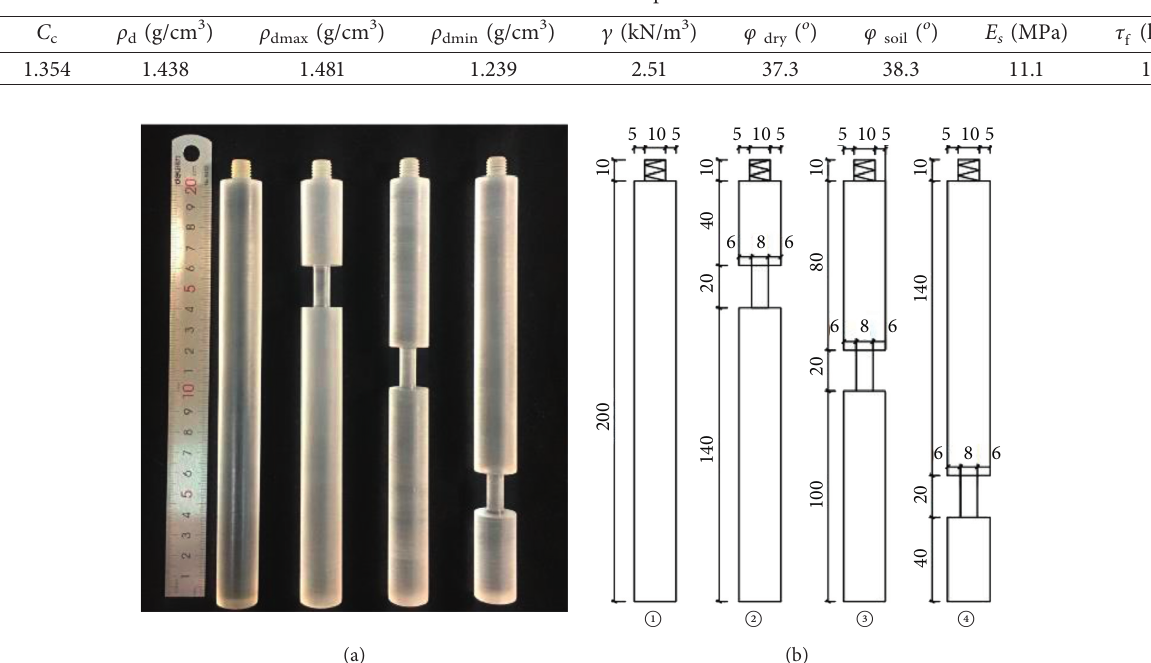
Figure 2: Gradation curve of the fused quartz Table 1: Parameters of transparent soil.